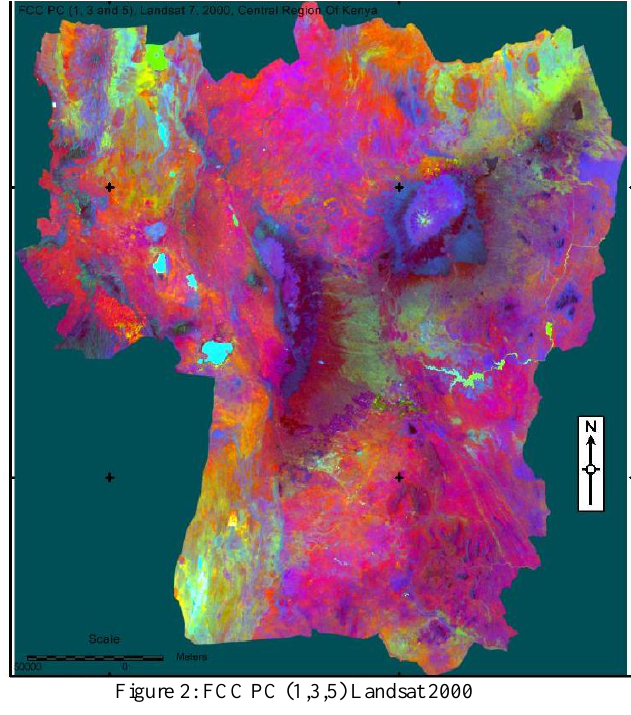
Figure 2: FCC PC (1,3,5) Landsat